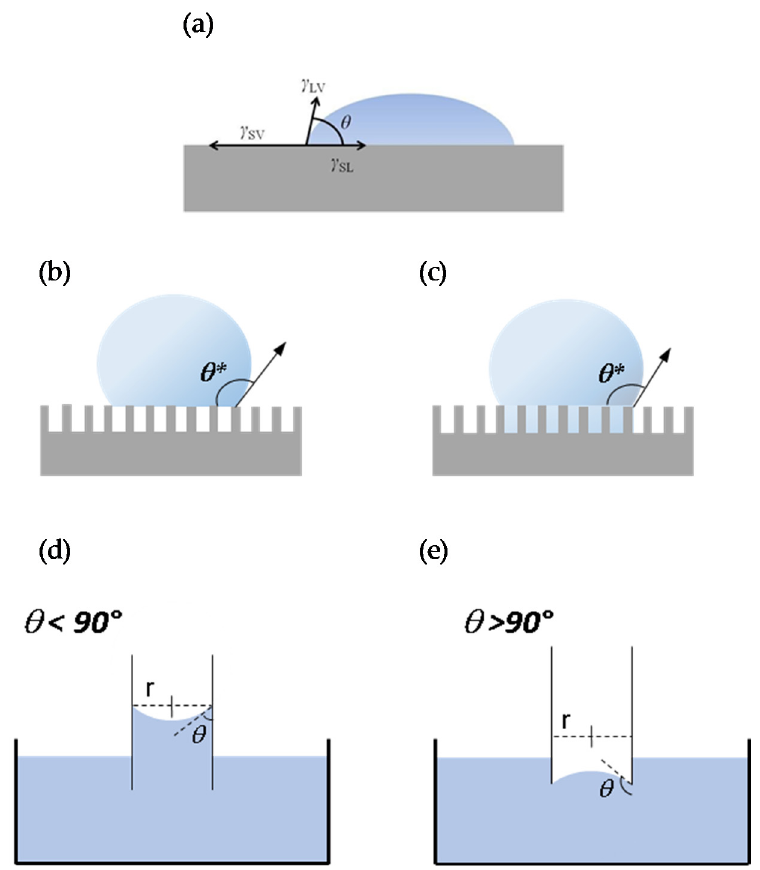
Figure 2. ( a ) Equilibrium among interface tensions in the liquid–solid–vapour system giving rise to the contact angle according to the Young’s equation; ( b ) interface on a textured surface according to the Wenzel and ( c ) Cassie–Baxter model; ( d ) capillary action with a hydrophilic and ( e ) hydrophobic capillary surface.